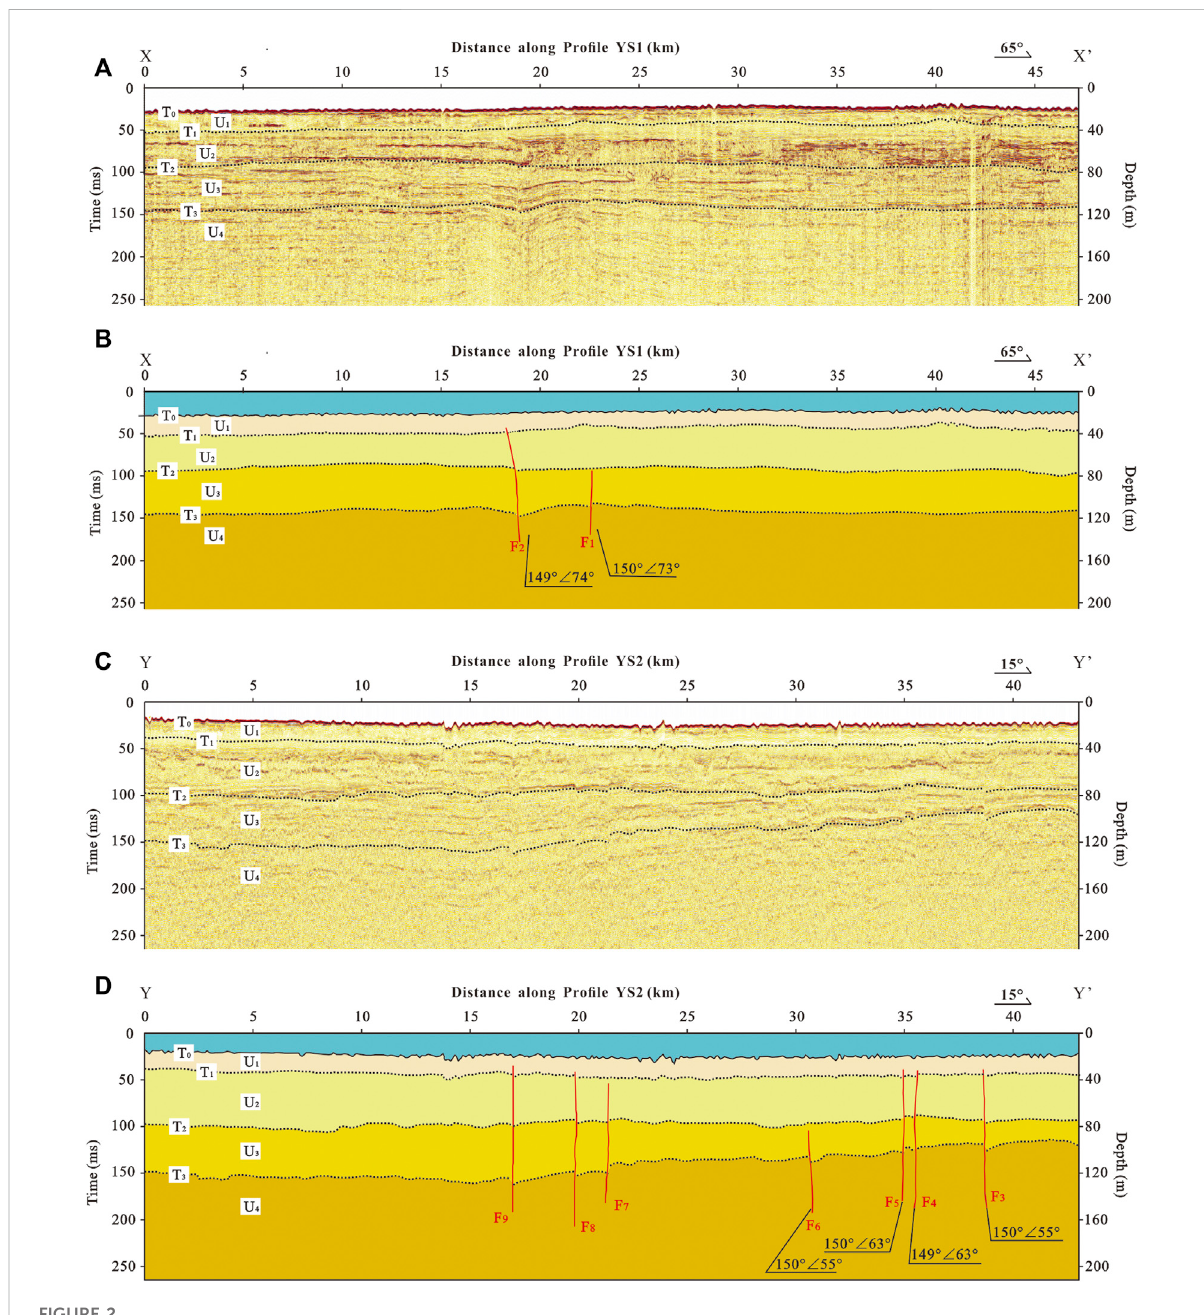
FIGURE 2 Seismic re fl ection pro fi les and interpretation results. (A,B) : YS1 pro fi le; (C,D) : YS2 pro fi le; T 0 – T 3 : seismic re fl ection interfaces; U 1 – U 4 : seismic